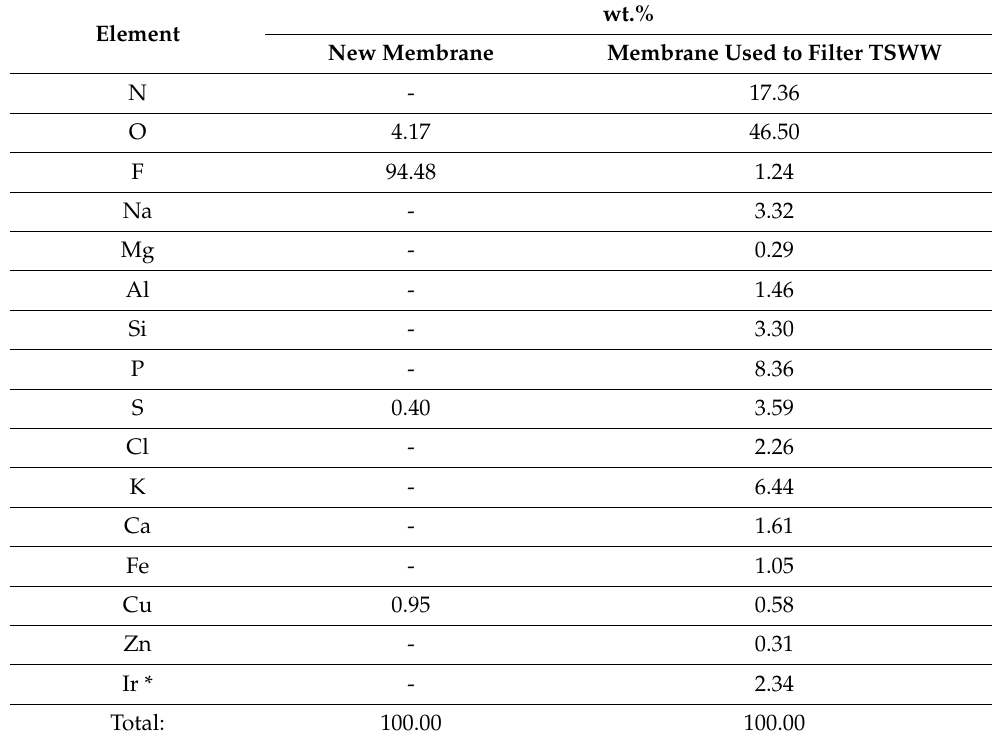
Table 7. EDS elemental composition of the new membrane in comparison with the membrane used to filter textile synthetic wastewater